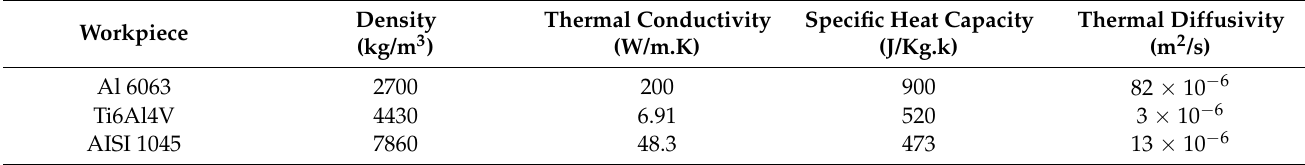
Table 1. Thermal properties of work-piece